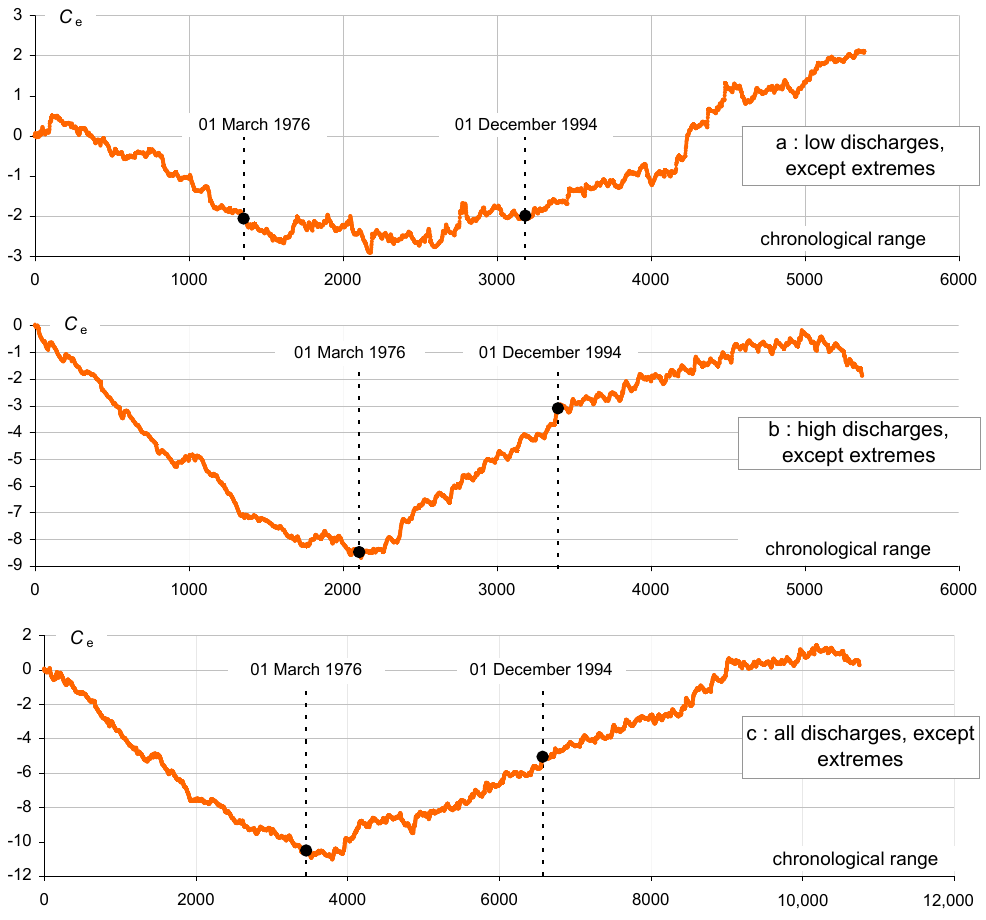
Figure 13. Chronological evolution of the cumulative error C e of model 2 with respect to the N = 10,966 observed values of K on the Bafing at Daka Saidou, for low flows with frequency of exceedance between 0.5 and 0.99 ( a ), high flows with frequency between 0.01 and 0.5 ( b ), and all flows except extreme flows, with frequency between 0.01 and 0.99 ( c ).